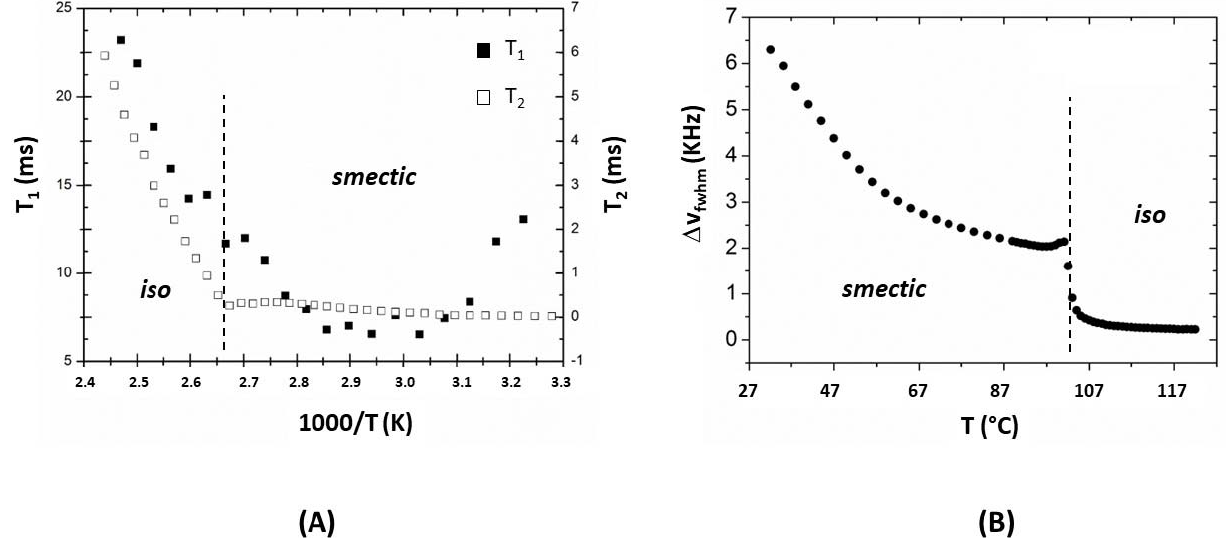
Figure 10. ( A ) 2 H NMR spin–lattice relaxation times (T 1 , ms) and spin–spin relaxation times (T 2 , μ s) as a function of 1000/T(K) of the SC LCE 2 ( D ) sample, deuterium labelled on the nematic comonomer, M4-d 2 . ( B ) 2 H NMR spectral line width ( ∆ ν , kHz), namely ∆ ν fwhm , as a function of temperature T ( ◦ C) of the SC LCE 2 ( D ), deuterium labelled on the nematic comonomer, M4-d 2 . Dashed vertical lines indicate the phase transition temperature.